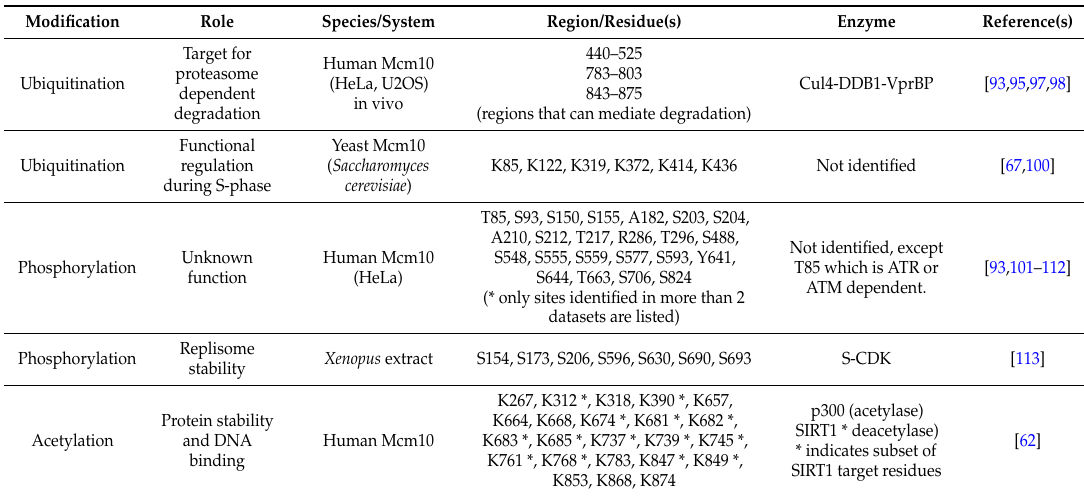
Table 1. Post-translational modifications of